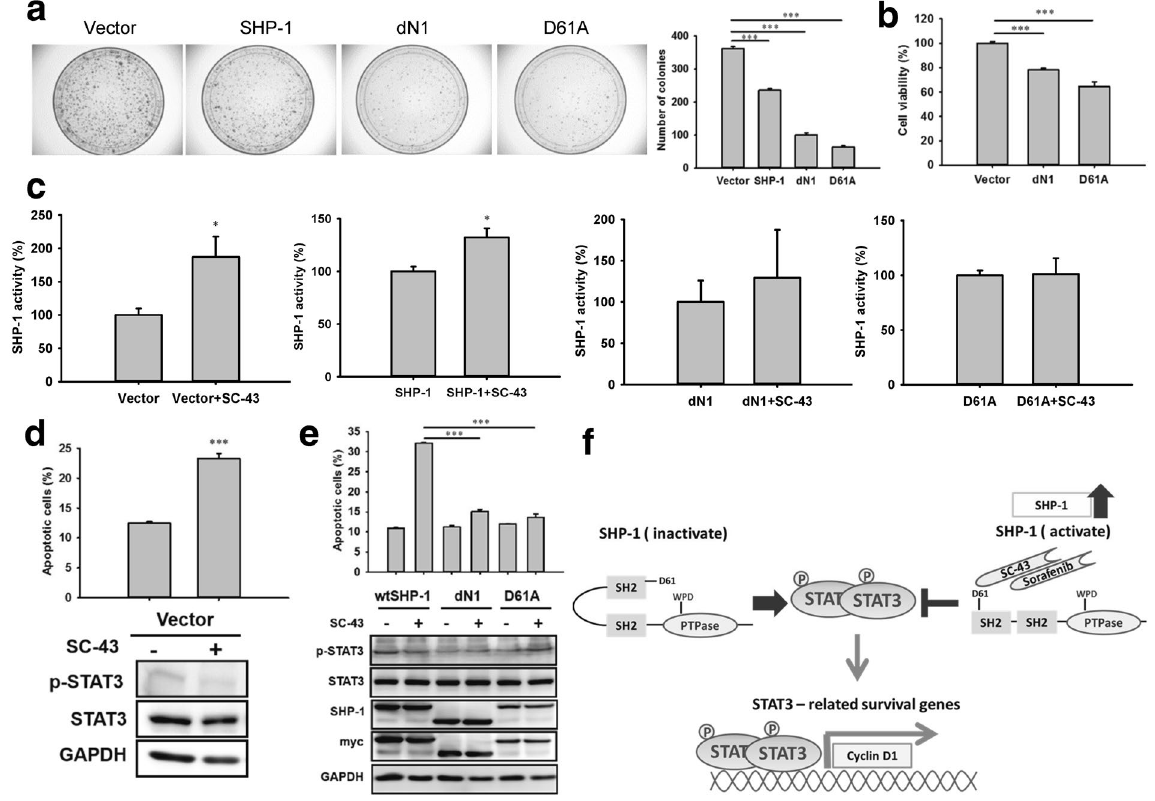
Figure 8. SC-43 activates SHP-1 by interaction with its inhibitory N-SH2 domain. ( a ) The ectopic expression of the SHP-1, dN1, D61A mutants significantly inhibited colony formation compared with the vector control after 14 days of incubation, as assessed using the colony formation assay. ( b ) Decreased cell viability of the dN1 and D61A mutants, as assessed using the MTS assay. ( c ) Significantly increased SHP-1 activity following the SC-43 treatment for the ectopic expression of the vector control and wild-type SHP-1 but not the dN1 and D61A mutants. The vector and myc-tagged SHP-1 mutants were expressed in LX2 cells. ( d ) Comparing the ectopic expression of the vector control, the SC-43 treatment (5 μ M, 24 h) significantly increased LX2 cell apoptosis and downregulated p-STAT3. ( e ) The SC-43 treatment (5 μ M, 24 h) significantly increased apoptosis and downregulated p-STAT3 in cells overexpressing wild-type SHP-1 but not the dN1 and D61A mutants. ( f ) Summary of the overall mechanisms. Columns: mean and bars: standard error (n = 3–5), * P < 0.05 and *** P <